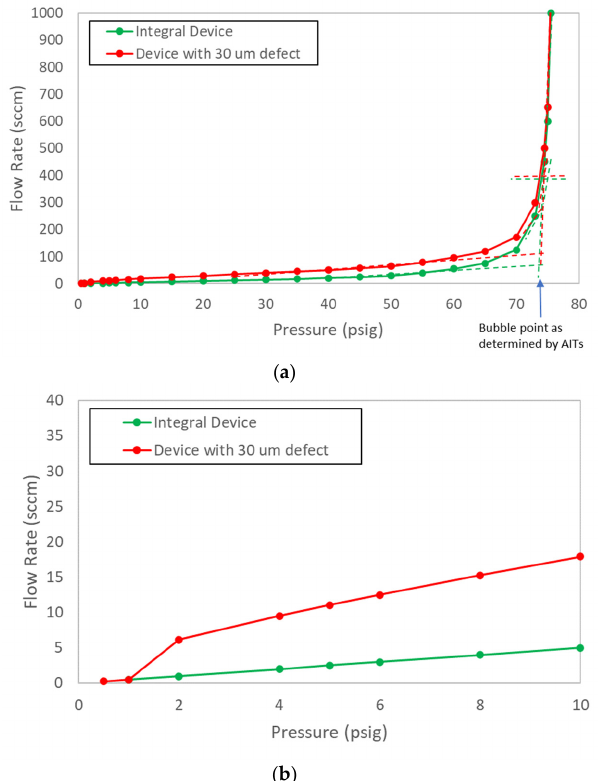
Figure 6. Hypothetical flow rate vs. pressure curve of Figure 5 with hypothetical 30 µm diameter defect: ( a ) full curve extended to 1 psi (7 kPa); ( b ) portion of curve below 10 psi (70 kPa).